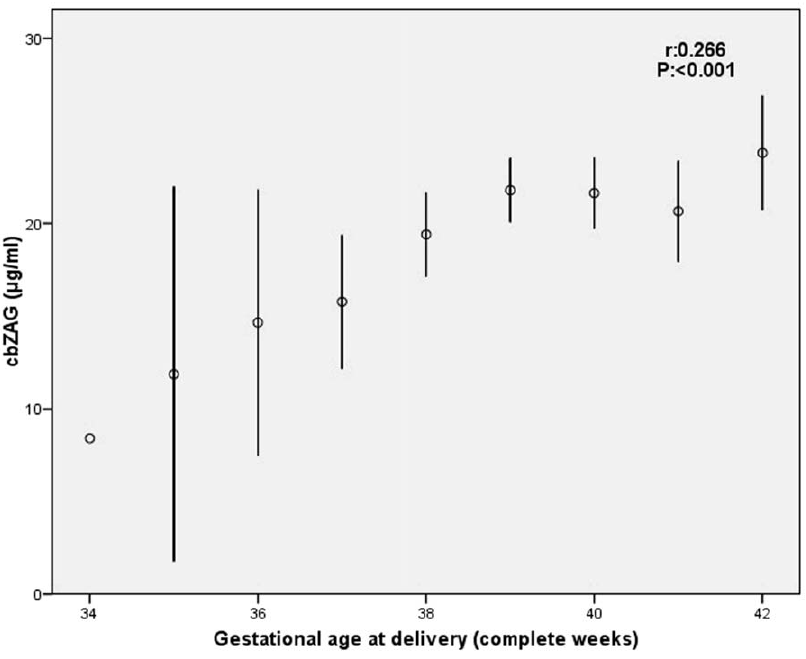
Figure 2. Relationship between serum cbZAG levels and gestational age at delivery.